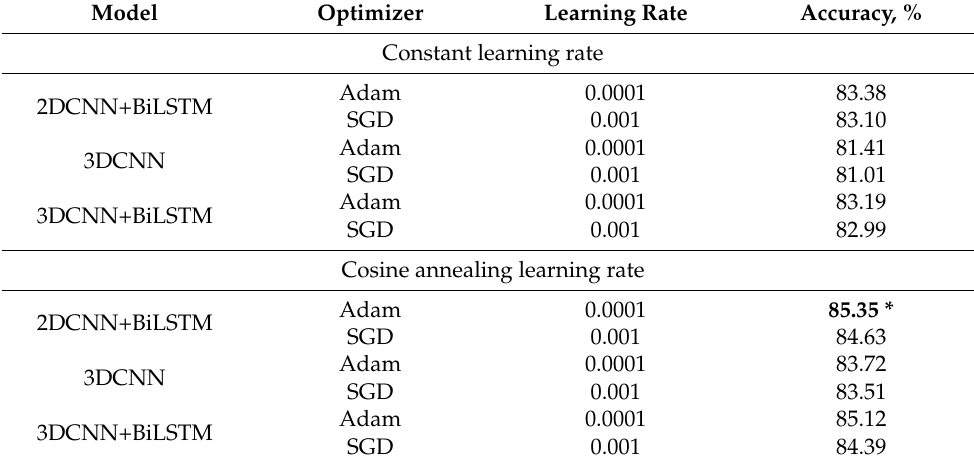
Table 3. Accuracy results of choosing the optimal visual